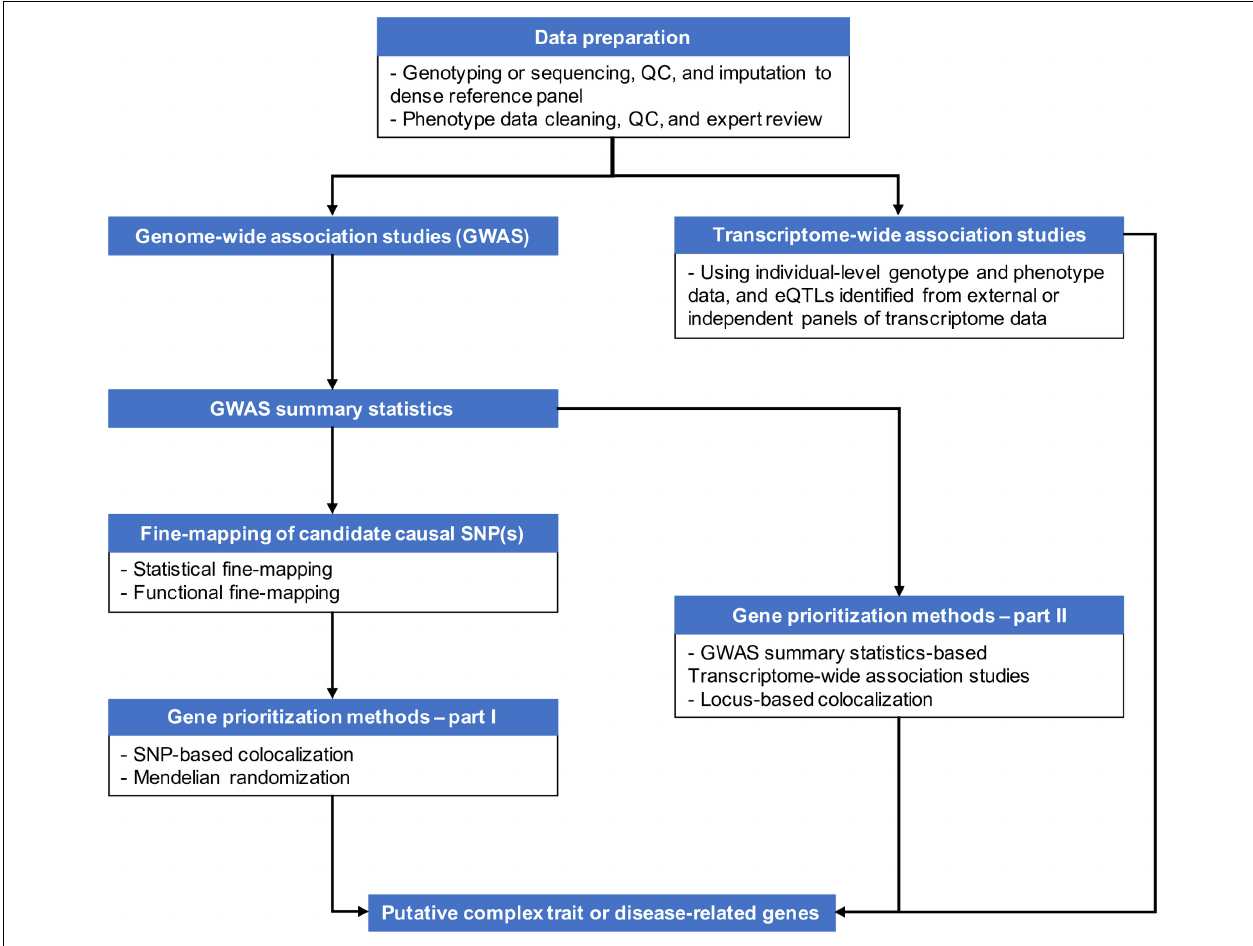
FIGURE 1 | An overview of strategies for gene-mapping following GWAS or parallel to GWAS.